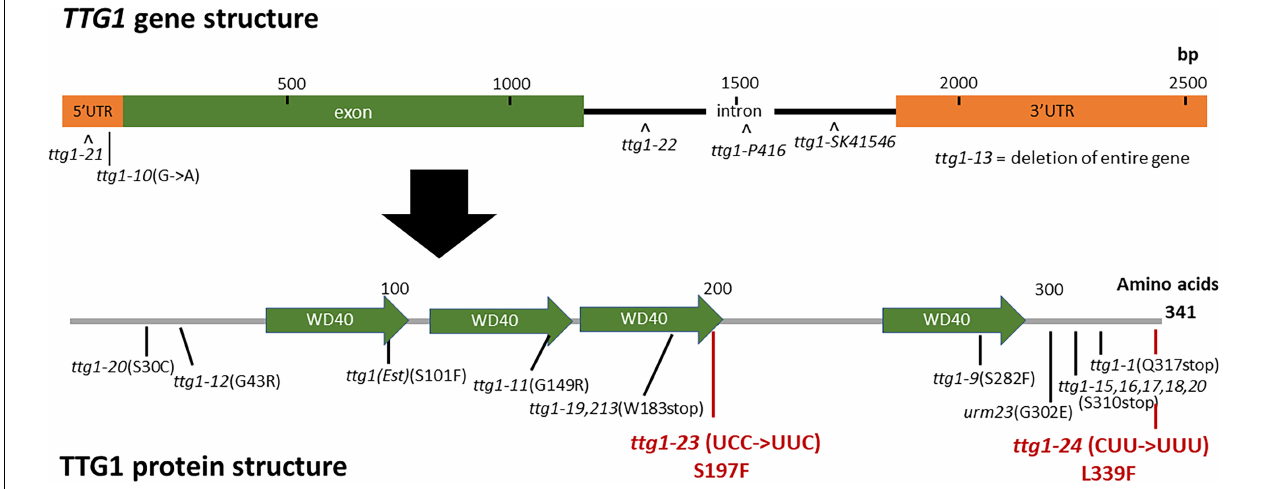
FIGURE 3 | TTG1 gene structure, protein structure, and mutations. The TTG1 gene structure was retrieved from TAIR. The protein domains and WD40 repeats were annotated by SMART. Previously characterized mutations are indicated in black; new mutations found in this study are indicated in red.